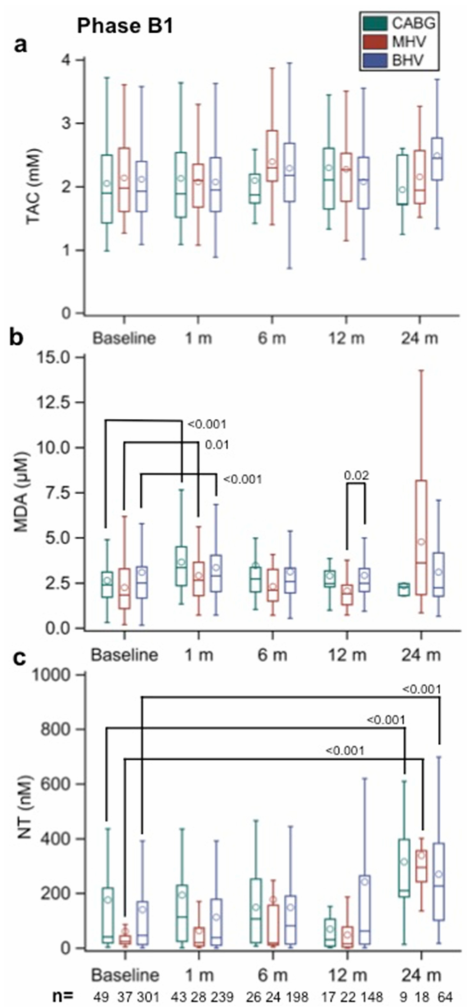
Figure 2. ( a ) Total antioxidant capacity (TAC, in mm), ( b ) malondialdehyde (MDA, in µ m), and ( c ) nitrotyrosine (NT, in nm) values in Phase B1 patients with implanted aortic biological heart valves (BHVs) at different time points (baseline and 1, 6, 12, and 24 months after implantation). Patients undergoing coronary artery bypass (CABG) surgery and aortic valve replacement with a mechanical heart valve (MHV) served as the controls. The numbers within the figures represent the p -values, and the numbers at the bottom of the figures represent the number of assessed patients. Multiple comparison adjustments were performed with Dunnett’s and Tukey–Kramer’s